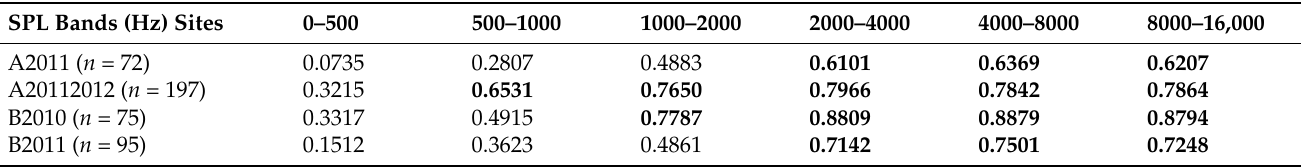
Table 2. Spearman’s correlation coefficient for daily-averaged wind data versus different sound pressure level (SPL) bands. Characters in bold indicate p < 0.05, ρ >